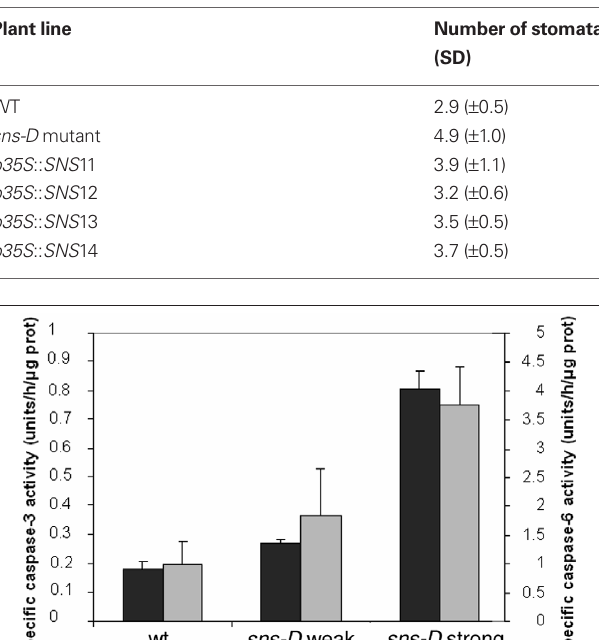
Table 2 | Number of stomata on adaxial side of leaves of 5-week-old plants on 10 − 8 m 2 tissue.